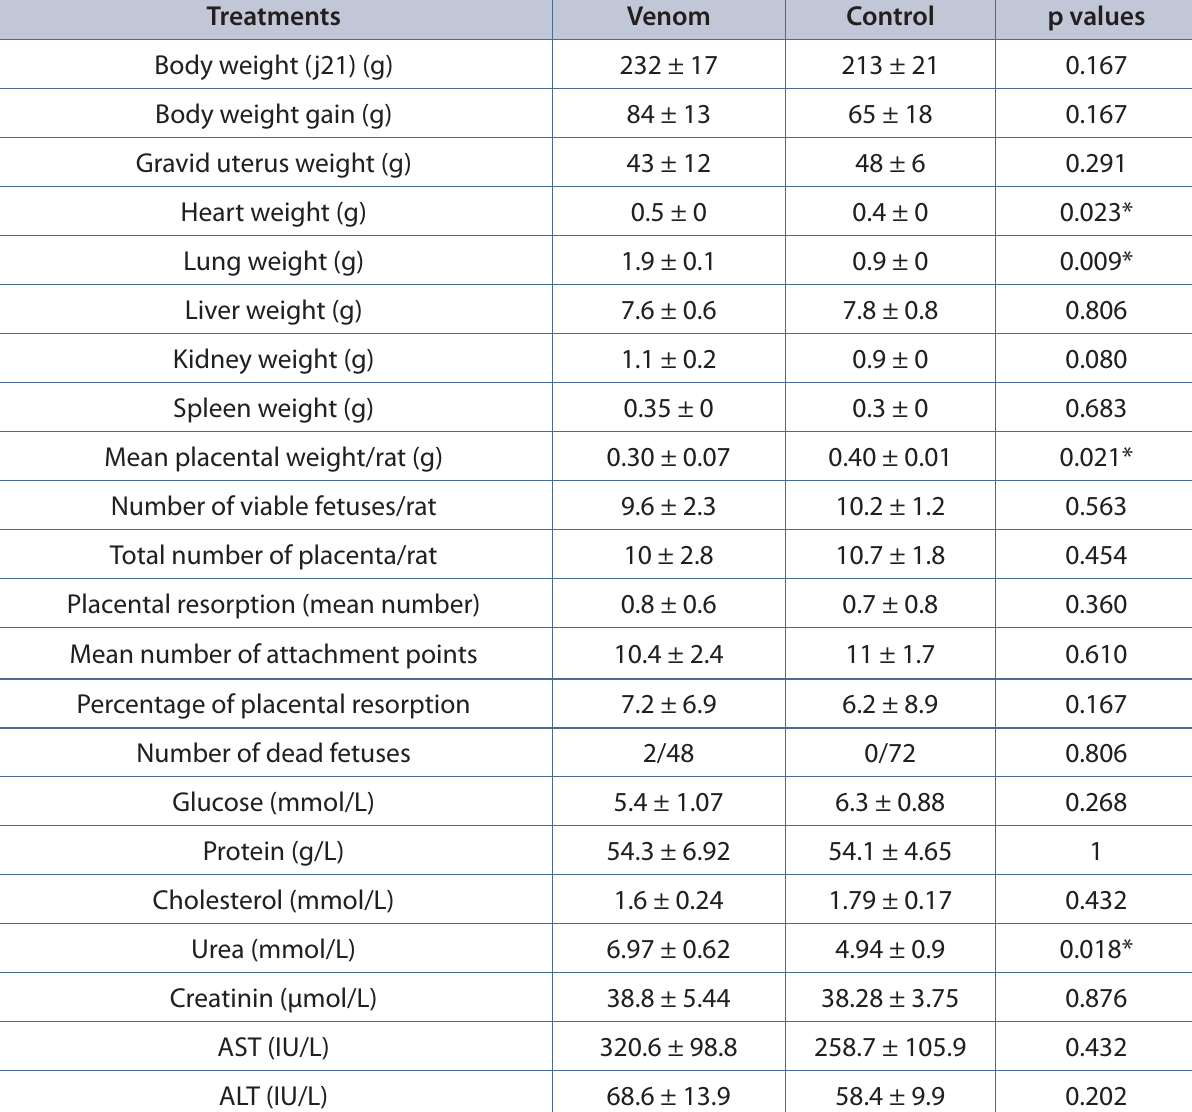
Table 1. Morphometric and biochemical parameters of rats following repetitive Buthus occitanus tunetanus venom exposure from the 7 th to 13 th day of